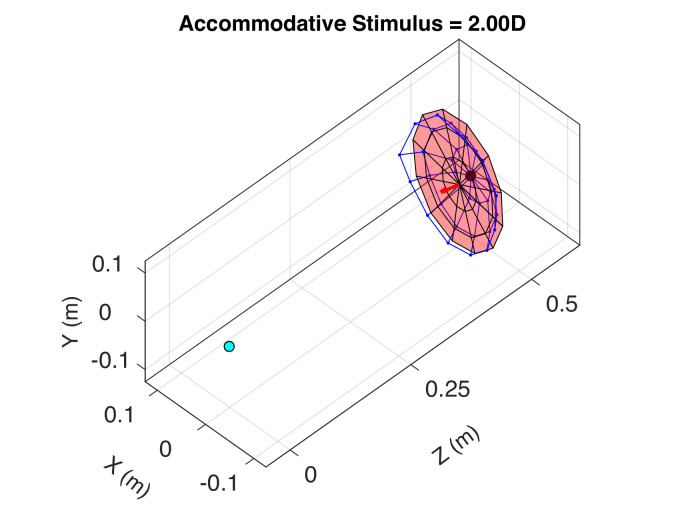
Retinal conjugate surface and accommodation. This is an animation of the best-focus surface averaged across subjects for accommodative stimuli of +2 to +4 D. In the computation, we used PSFs and the Strehl Ratio. The blue circle represents the left eye and the red circle the accommodative stimulus (corrected for lag and lead errors at the fovea). The blue mesh is the best-focus surface. The pink plane is the plane that best fits the mesh. The arrow is that plane's surface normal. Upper visual field is on the top and nasal field on the right. Please visit the article on the journal website to play the movie.